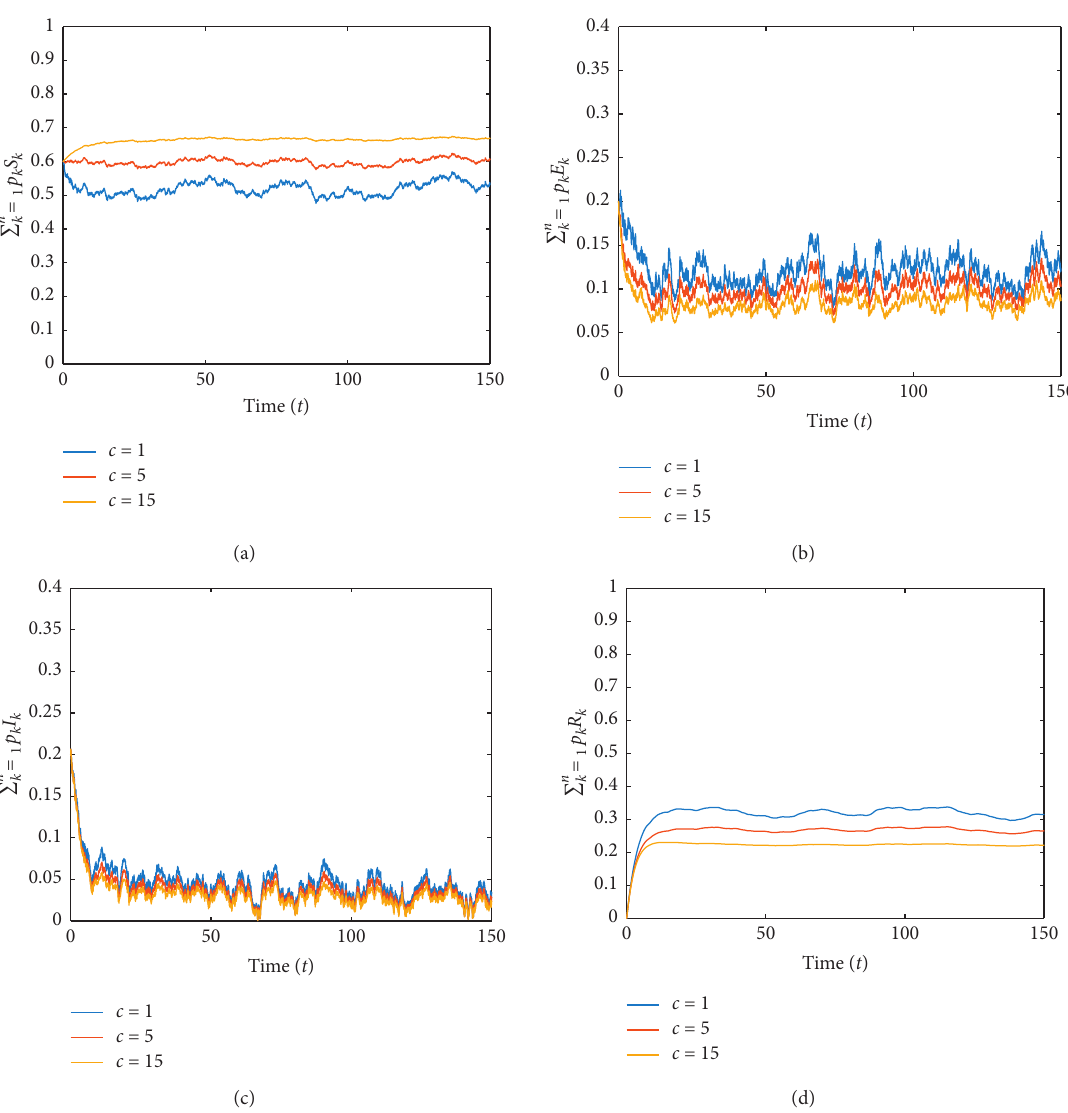
Figure 3: Under the initial conditions given in Example 3, the time evolution of each state mean in the stochastic model with c � 1 , 5 , 15,